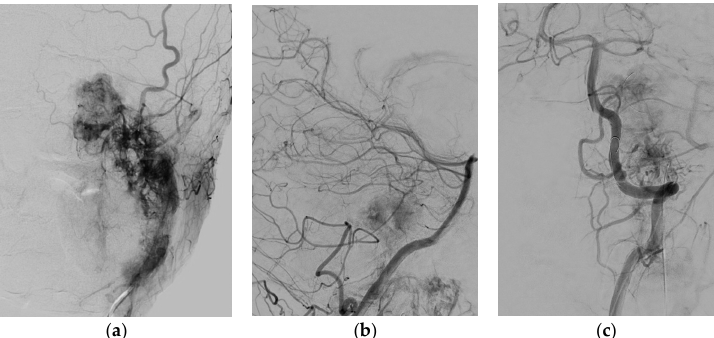
Figure 2. ( a ) Superselective DSA of the external carotid artery of the high vascularized tumor; ( b , c ) DSA demonstrate feeding vessels of intradural tumor from the vertebral artery.